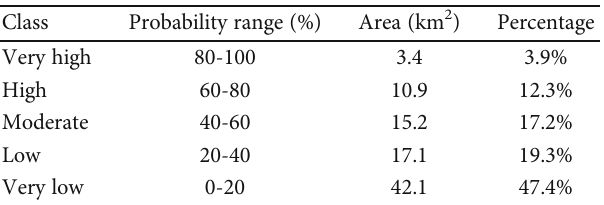
Table 2: The landslide probability distribution in Ikizce-Caybasi Area